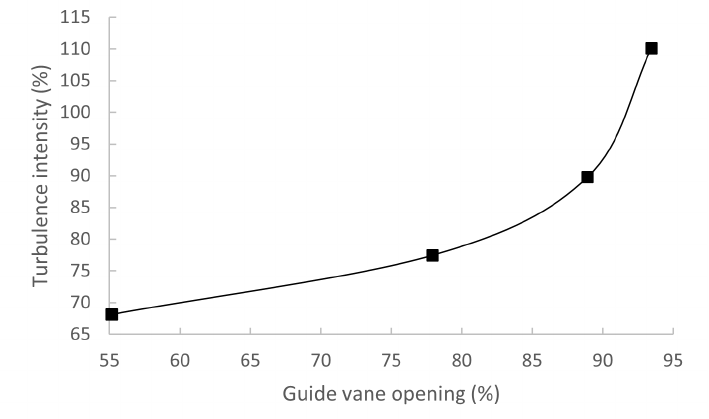
Figure 14. Flow turbulence intensity for different operating